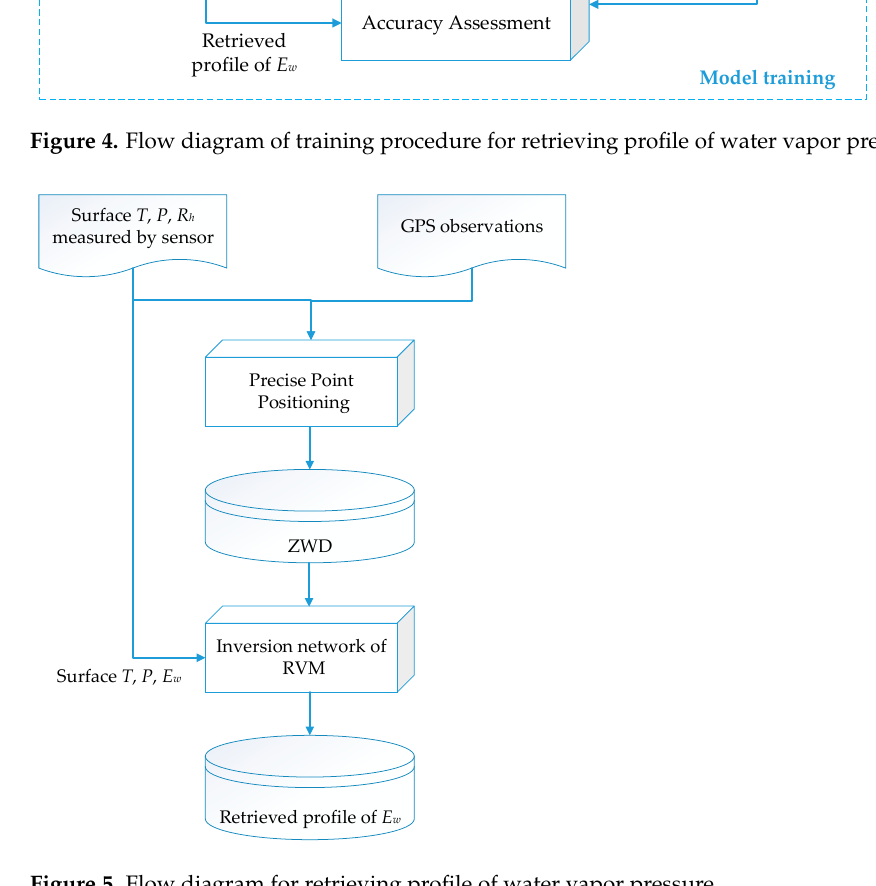
Figure 5. Flow diagram for retrieving profile of water vapor